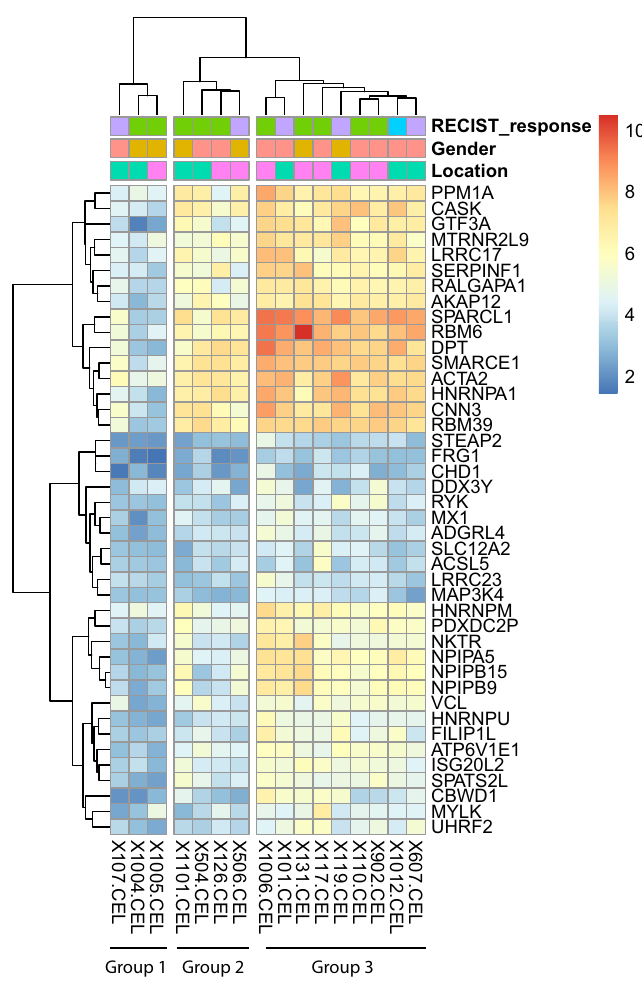
Fig. 3 | Heatmap clustering of patients based on gene expression pro fi ling. Patients(columns; n =16)wereclusteredinthreegroupsbasedonacombinationof mRNA differentially expression data (rows), modeled according to patient response ( fi tting a linear modelthrough limmapackage).Zooming to column-wise